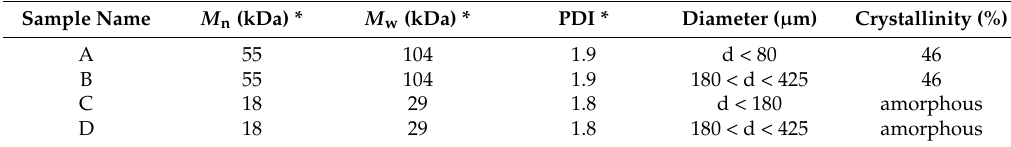
Table 1. Characterization of the synthesized PEF powders. PDI: polydispersity index.